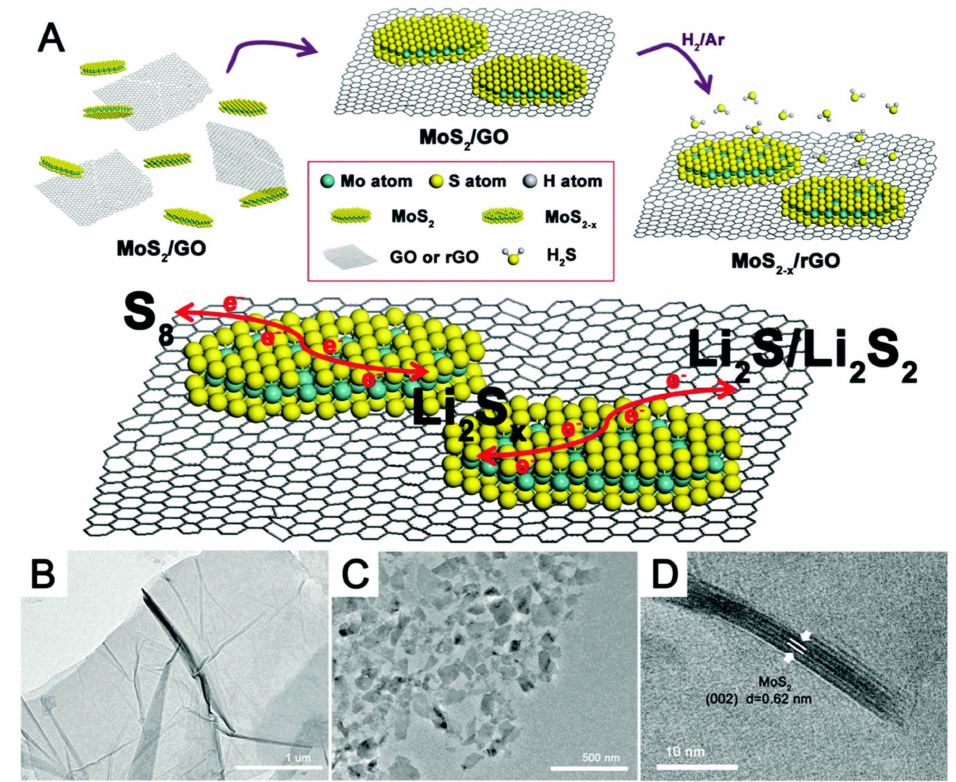
Figure 6. ( A ) Schematic of the synthesis of the MoS 2 − x/rGO composite and the conversion of Li 2 S x on the MoS 2 − x/rGO surface. TEM images of ( B ) a thin GO film and ( C ) MoS 2 nanoflakes. ( D ) HRTEM image of MoS 2 nanoflakes. Adapted with permission [22]. Copyright (2017) The Royal Society of chemistry. This article is an open access article distributed under the terms and conditions of the Creative Commons Attribution (CC BY) license.